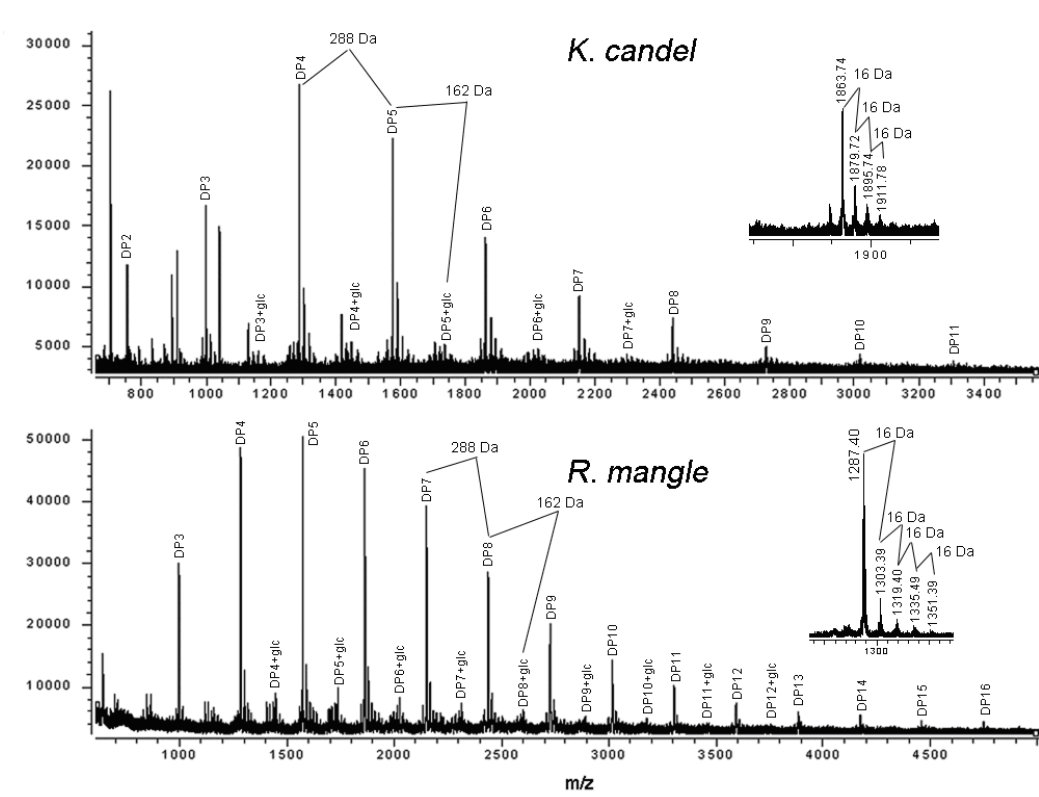
Figure 2. MALDI-TOF positive reflectron mode mass spectra of the condensed tannins from K . candel and R. mangle . Inset is an enlarged spectrum of masses representing a procyanidin series with varying hydroxylation patterns.